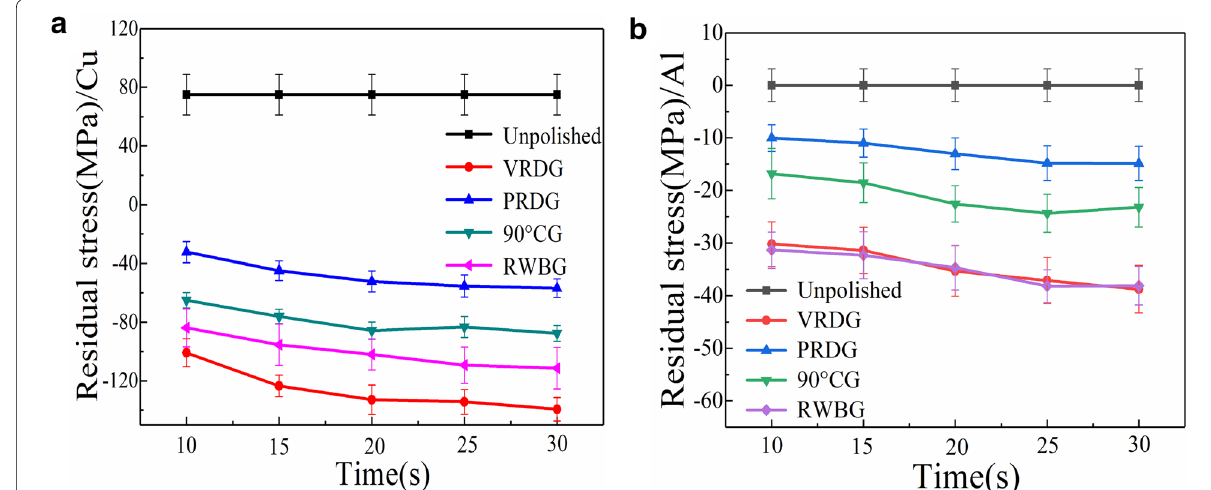
Fig. 4 Surface residual stress with different mechanical treatments: a Cu plate; b Al plate